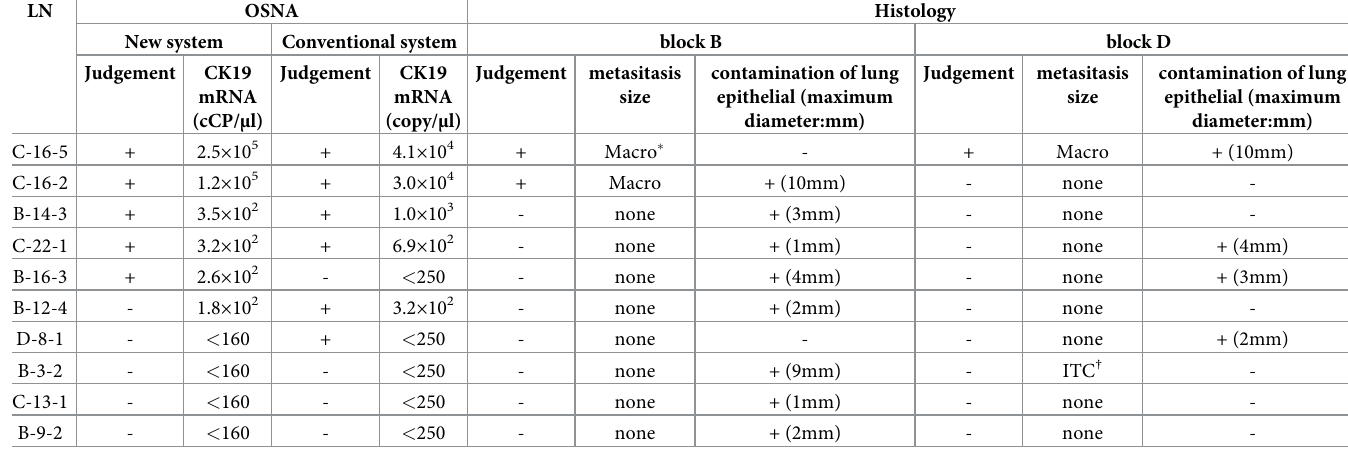
Table 5. Lymph node specimens including lung epithelial